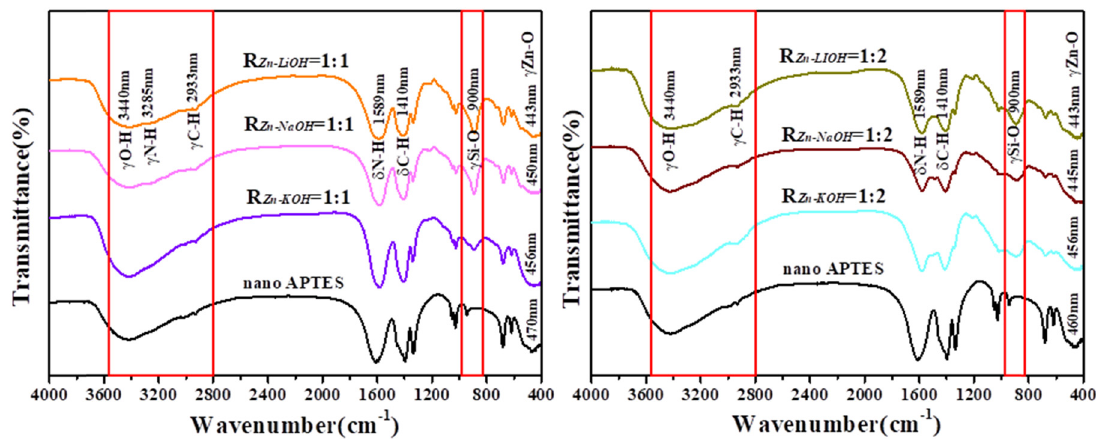
Figure 5: IR spectra of ZnO QDs synthesized with di ff erent alkali bases and di ff erent R Zn − OH values.